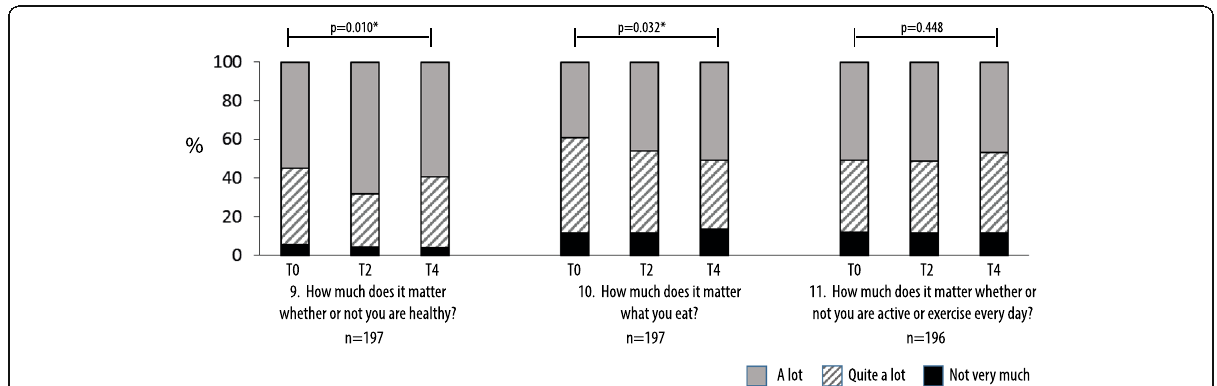
Fig. 5 The importance of health and lifestyle. Matched pre-post responses, n = 201. Variance in proportion of responses confirming “ a lot ” vs less than “ a lot ” was assessed via related samples Cochran ’ s Q test, *significant ( α =0.05). The effect of gender on responses was measured using a cumulative odds ordinal logistic regression with proportional odds. A significant difference in response based on gender was identified for statement 10 at T2 where the odds of boys identifying that what you eat mattered a lot was 0.4 times that of girls, p =